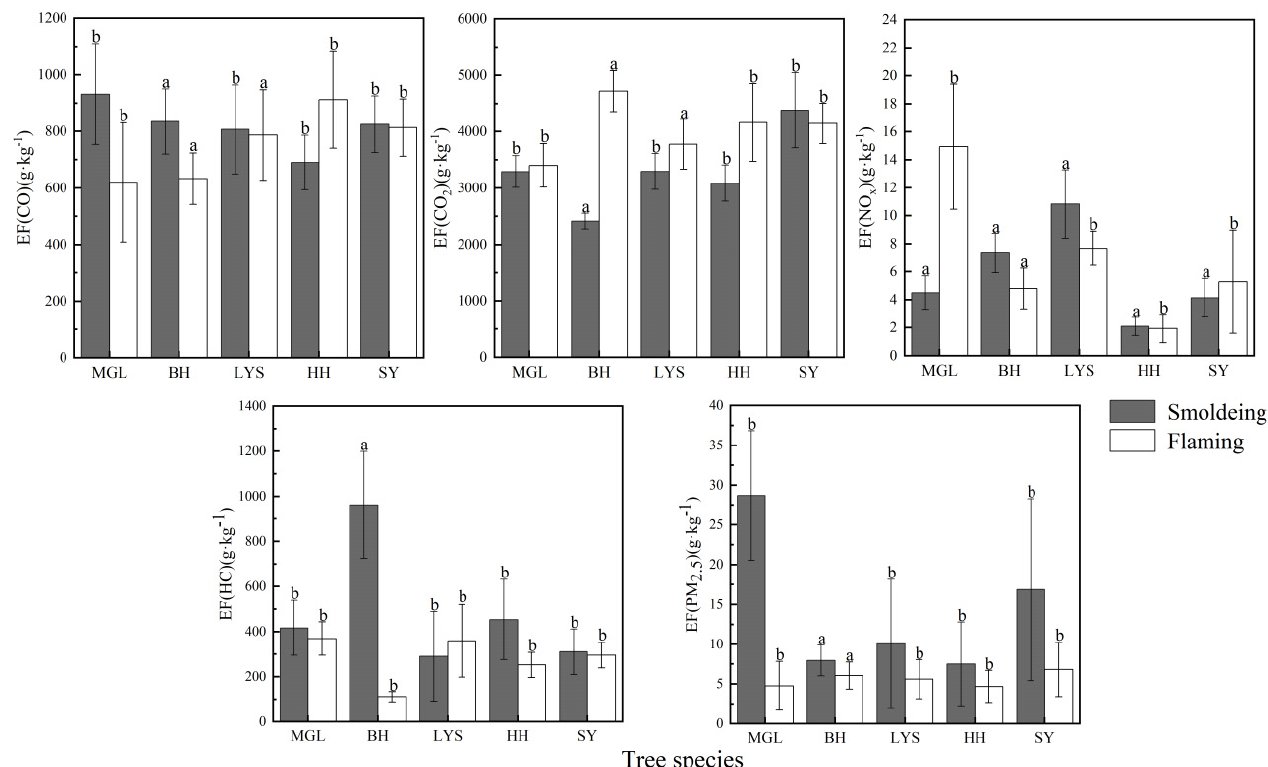
Figure 3. Emissions released by five trees under different combustion states. Note: SY, Populus davidiana ; BH, Betula dahurica ; LYS, Larix gmelinii ; HH, Betula platyphylla ; MGL, Quercus mongolica . Identical letters indicate no significant difference, while different letters indicate a significant difference between the treatment and the control; the same below.